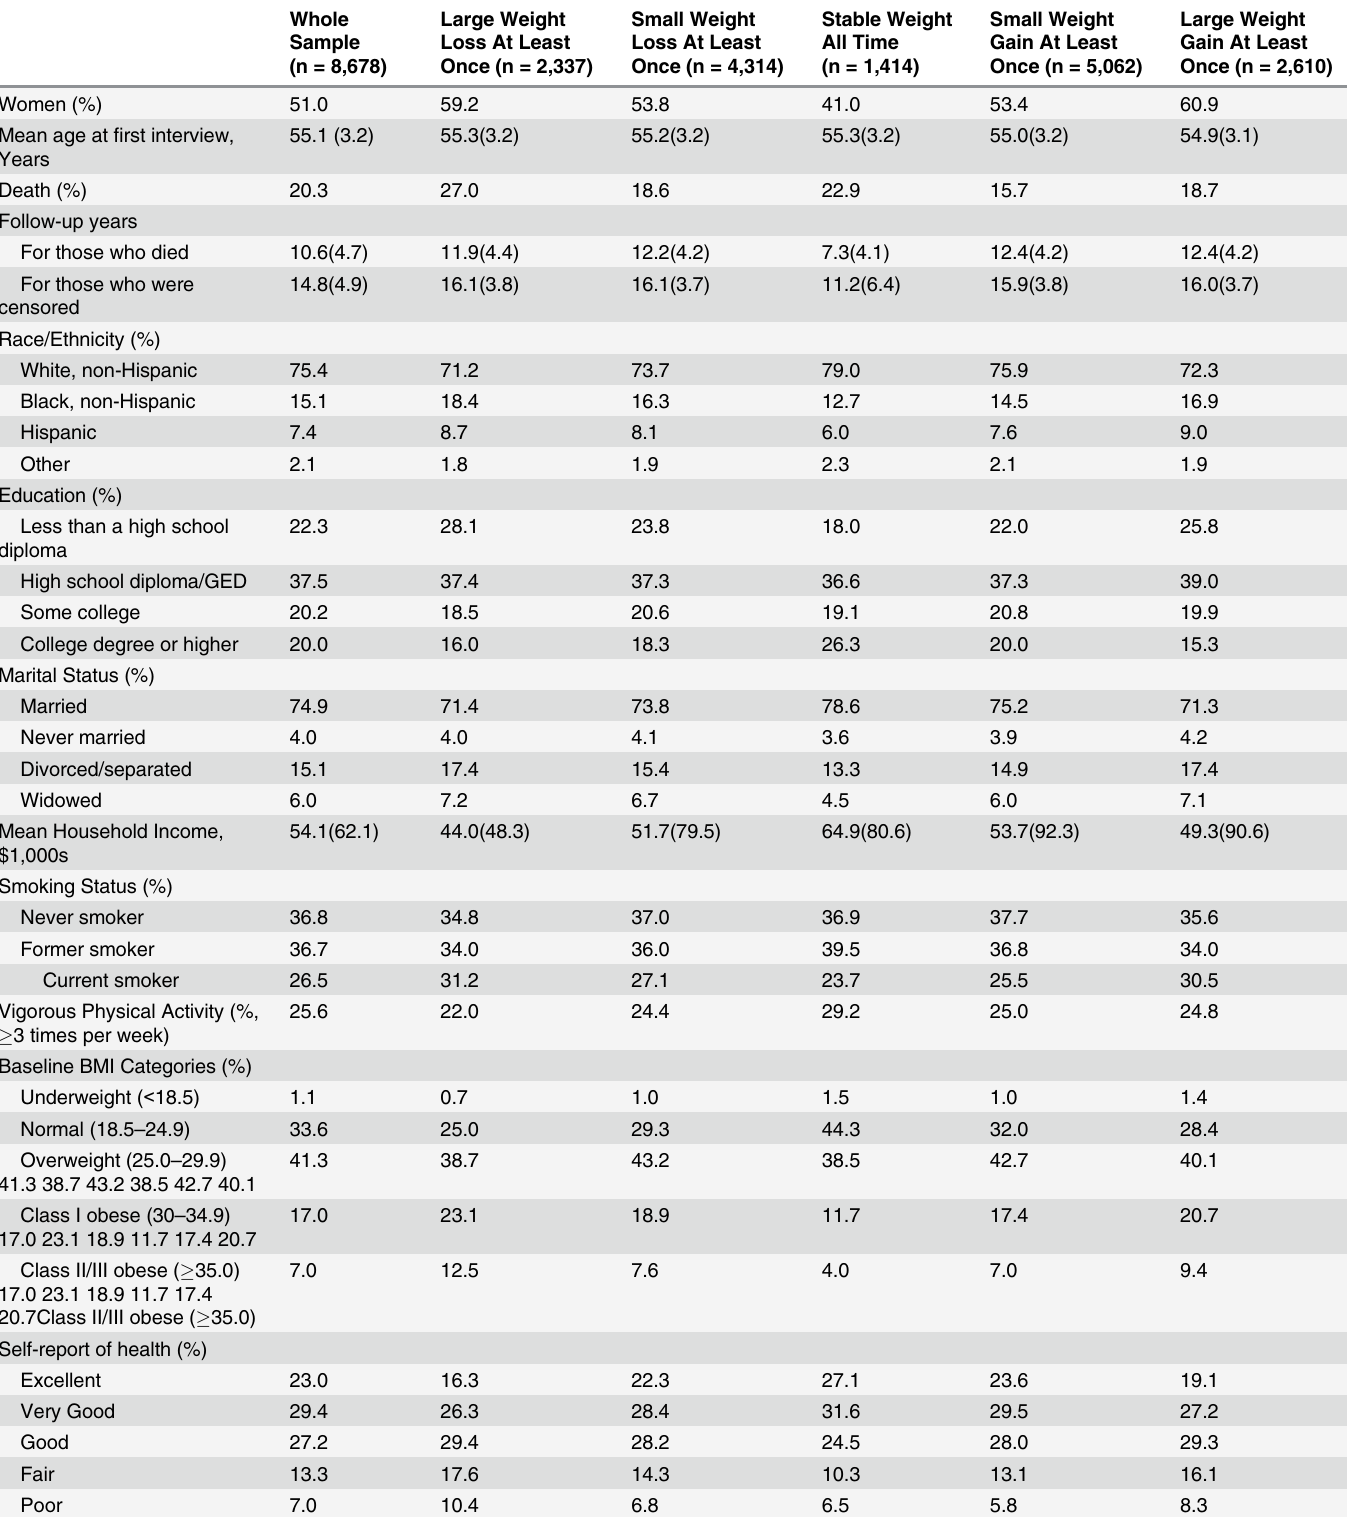
Table 1. Baseline Characteristics by Weight Change Status through All